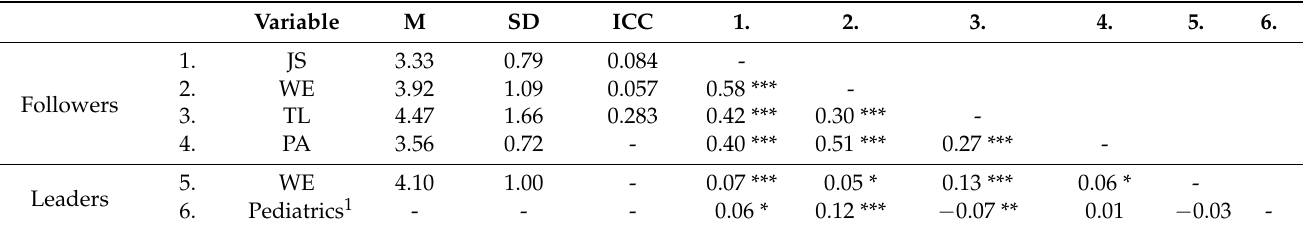
Table 2. Correlations of